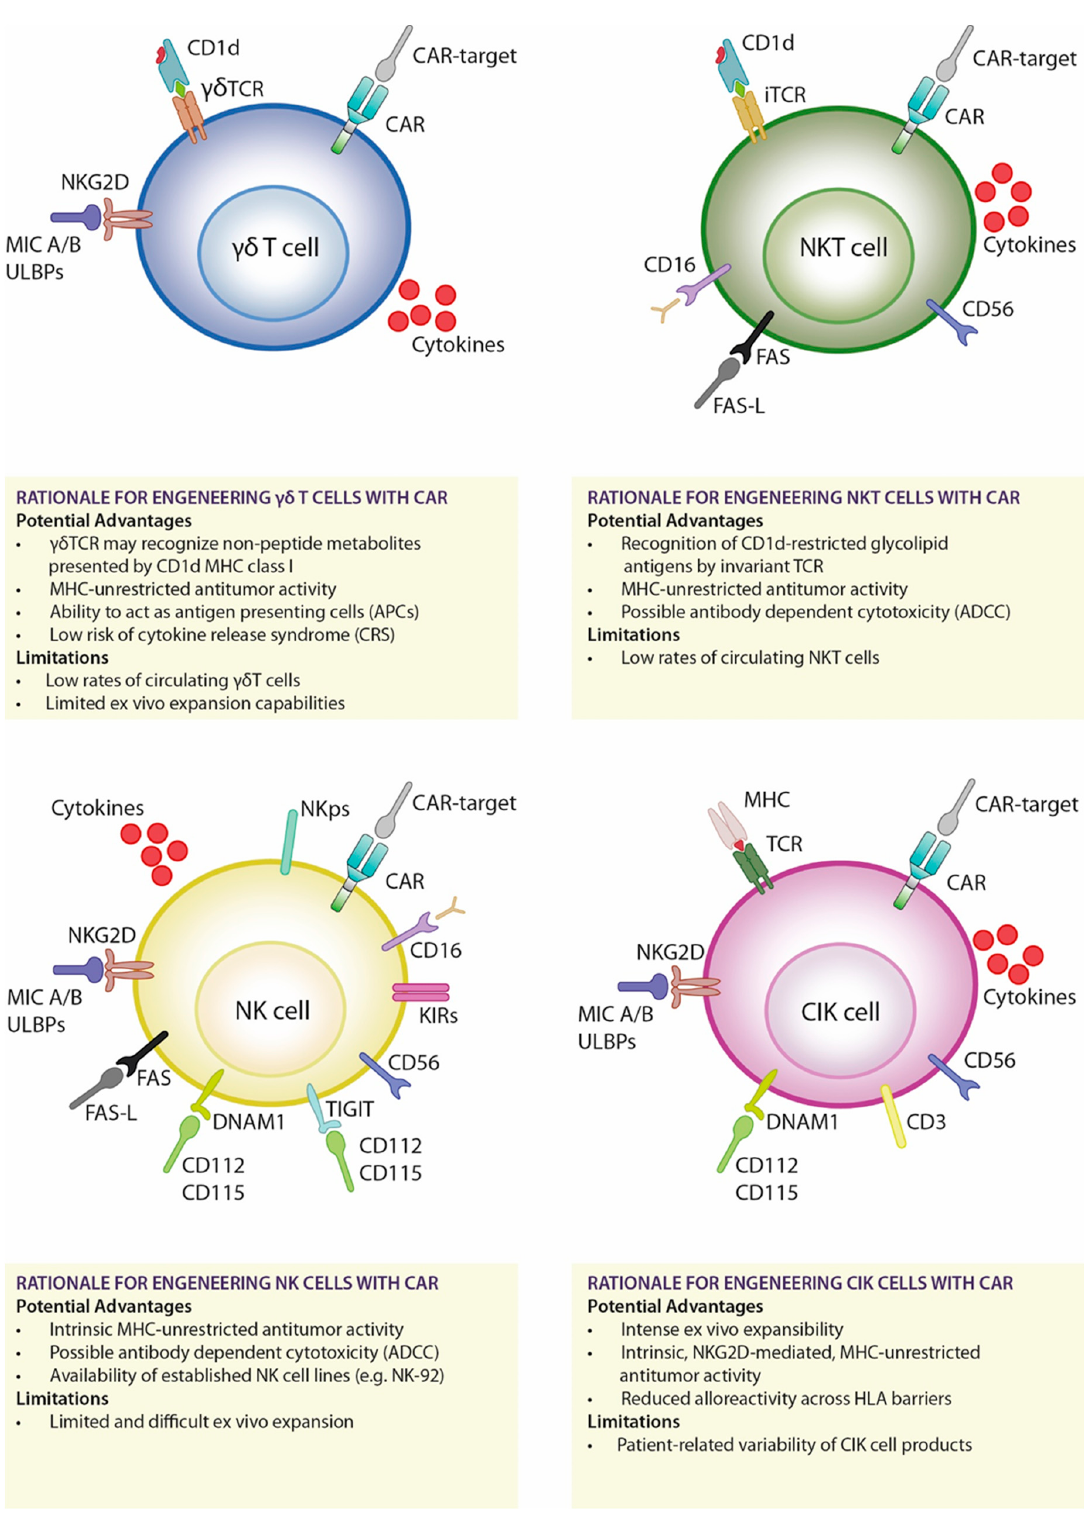
Figure 1. Main potential advantages and limitations of alternative cell types for CAR engineering. MHC, major histocompatibility complex; HLA, human leucocyte antigen; TCR, T cell Receptor; CAR, Chimeric Antigen Receptor; CD, Cluster of Di ff erentiation; NKG2D, Natural Killer Group 2D receptor; MIC A / B, MHC class I chain-related gene A / B; ULBPs, UL16 binding proteins; KIR, killer immunoglobulin-like receptor; TIGIT, T cell Immunoglobulin and ITIM domain; DNAM-1, DNAX Accessory Molecule-1; NK, natural killer; CIK, Cytokine Induced Killer; APC, antigen-presenting cell; CRS, Cytokine Release Syndrome; ADCC, antibody dependent cellular